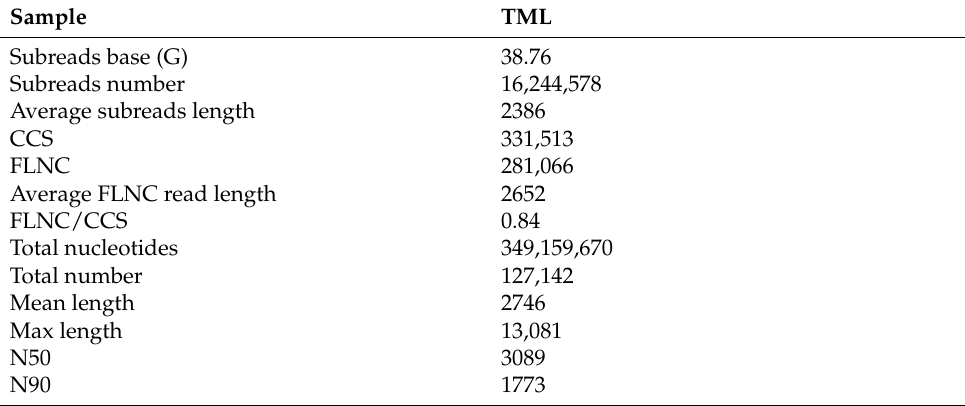
Table 1. The characterization of the full-length transcriptome of